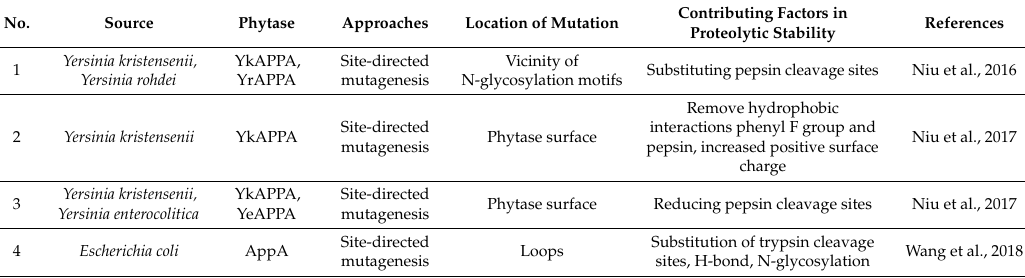
Figure 10. Proteolytic stability factors in YkAPPA, YeAPPA and YrAPPA phytases. Table 3. Factors contributing to proteolytic Table 3. Factors contributing to proteolytic stability.